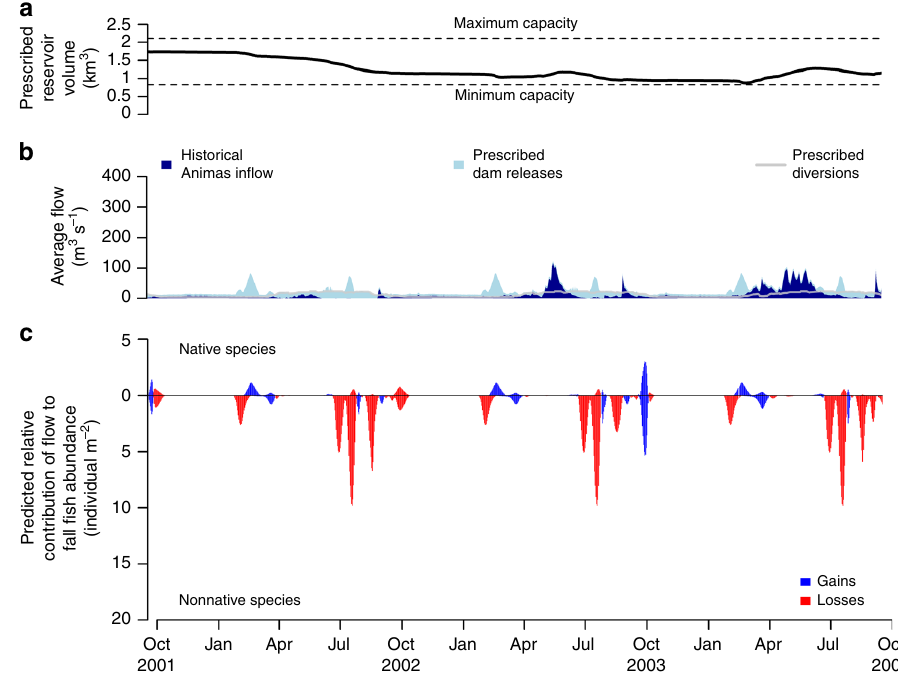
Fig. 4 Designer fl ow prescription balancing human and ecological objectives from 2001 to 2004 during the dry (low- fl ow) period. Designer fl ow prescription indicated by triangle symbol in Fig. 2a. The depicted designer fl ow heavily prioritized human water needs and focused equally on native species abundance gains and nonnative species abundance losses (90%/5%/5% respective priority split). a Prescribed reservoir volume; b Cumulative plot of historical Animas River in fl ow (dark blue) and prescribed Navajo Dam releases (light blue), with prescribed water diversions downstream of Navajo Dam overlaid (gray); c Predicted relative abundance gains (blue) or losses (red) of native (above zero axis) and nonnative (below zero axis) fi shes in response to fl ow designs (individual/m − 2 on log scale)